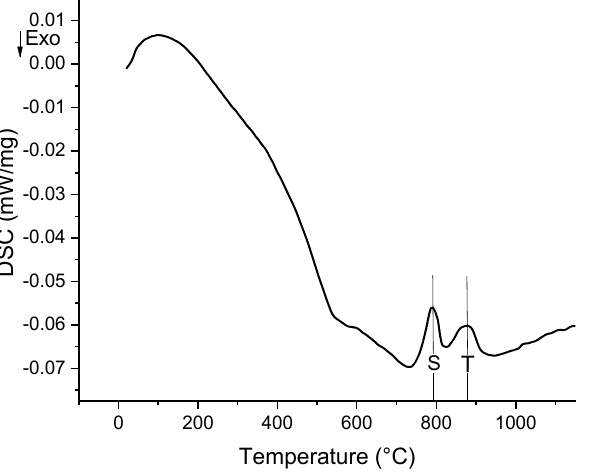
Figure 2. DSC curve of N36 zirconium alloy executed at constant heating rate of 5 °C/min.